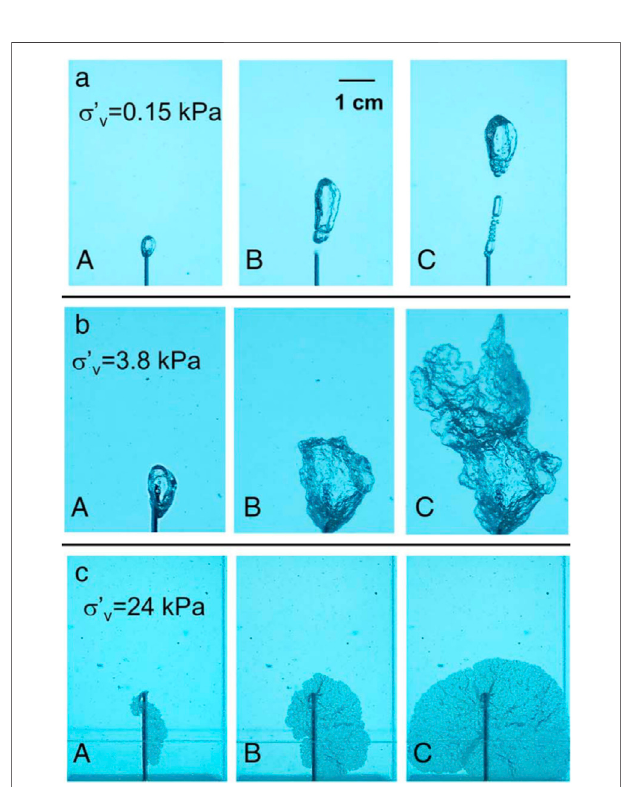
FIGURE11| Grain-displacivegasmigrationinatransparent fi ne-grained granular medium at different vertical effective stress levels: (A) bubble at σ ′ (cid:1) 0 . 15kPa; (B) cavity expansion followed by planar opening at σ ′ (cid:1) 3 . 8kPa; and (C) open discontinuity at σ ′ (cid:1) 24kPa (Sun and Santamarina,